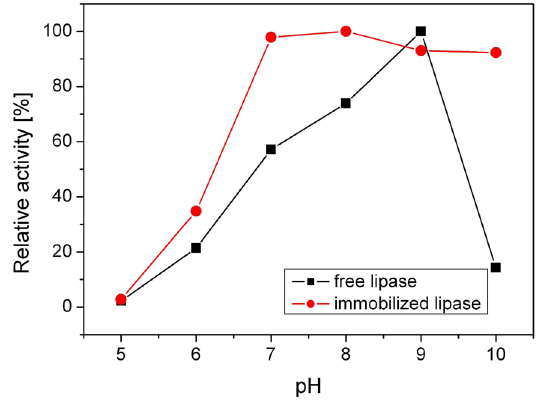
Figure 13. Particle size distribution of silica core/ferrite shell particles with deposited external silica layer (sample CF4-S).